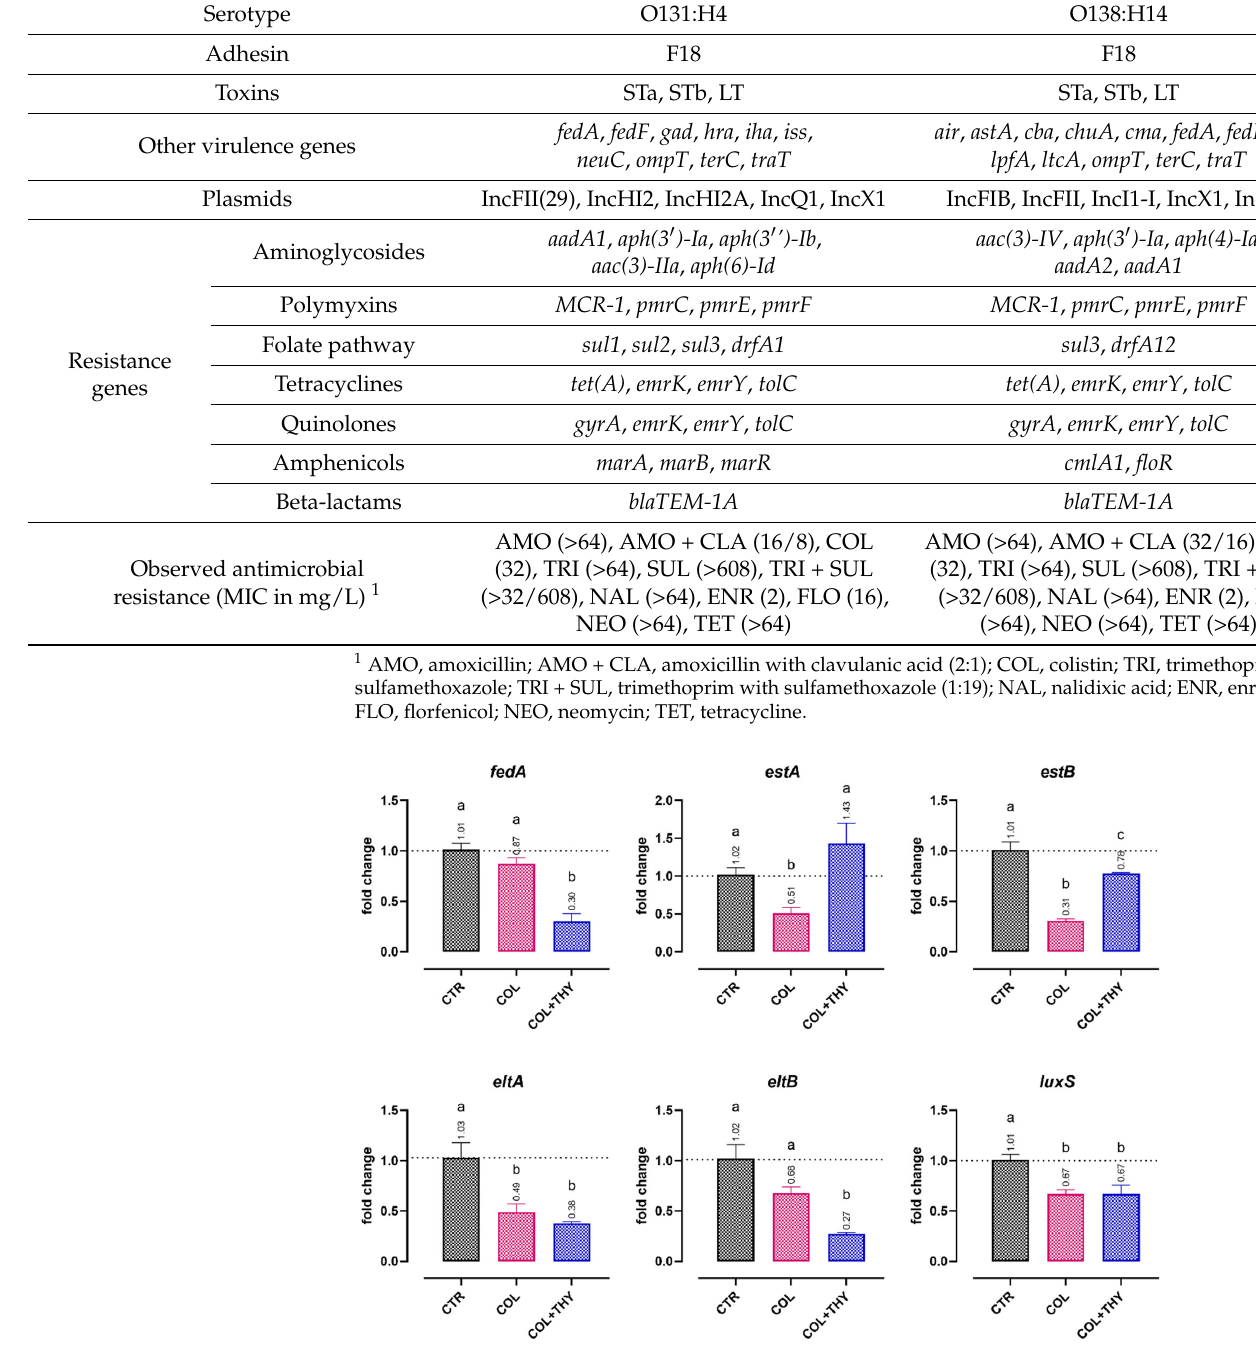
Figure 2. Effects of colistin (MIC/4, 8 mg/L, COL) or a combination of colistin and thymol